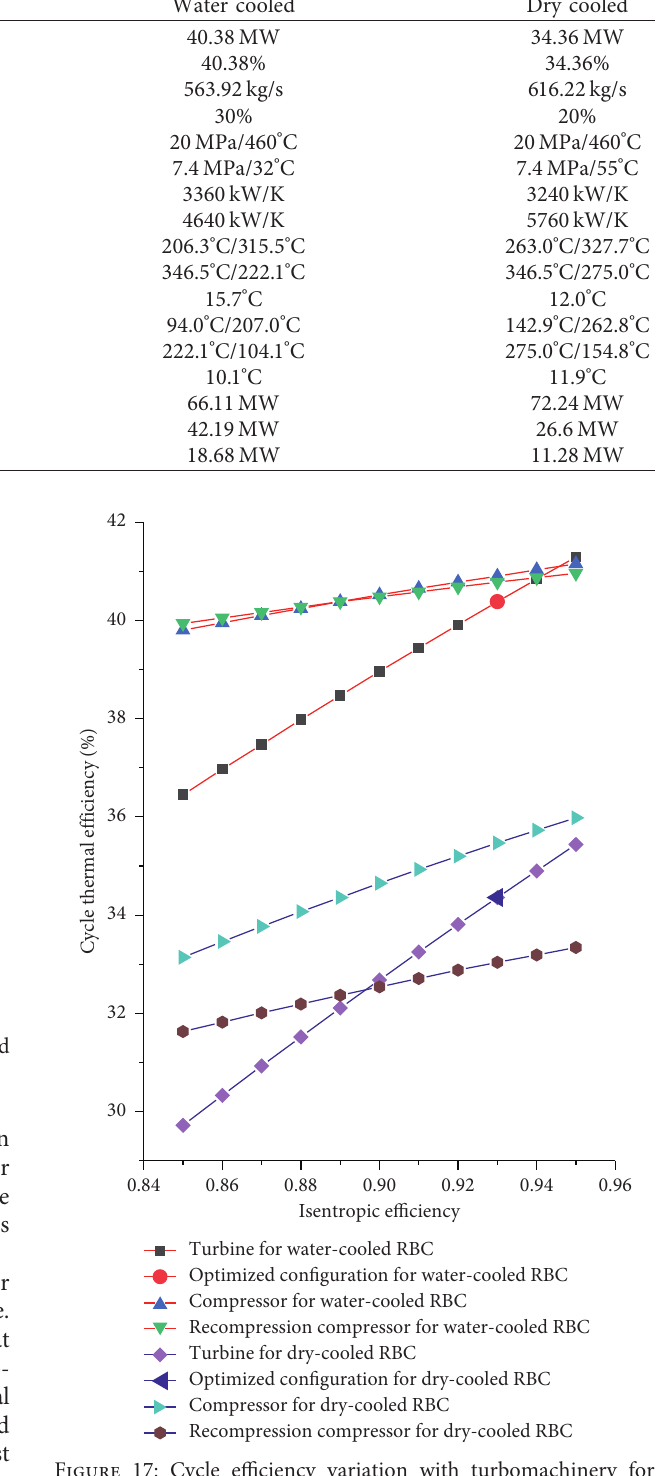
Figure 17: Cycle efficiency variation with turbomachinery for water-cooled and dry-cooled recompression Brayton